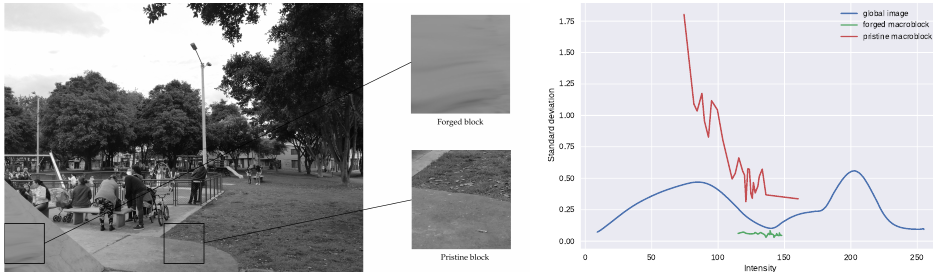
Figure 1. Estimated noise curves for the global image and for two macroblocks—one of which is contained in the manipulated region and the other is coming from the non-manipulated part of the